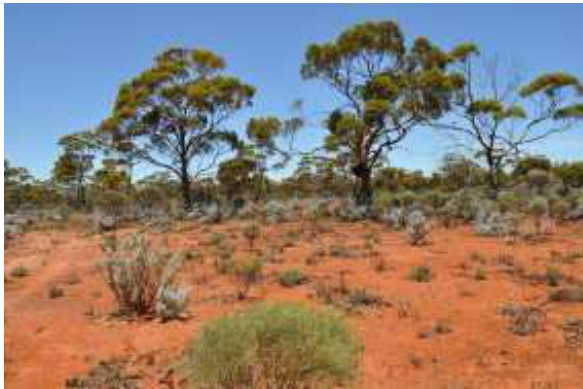
Figure 3. The Credo field site.